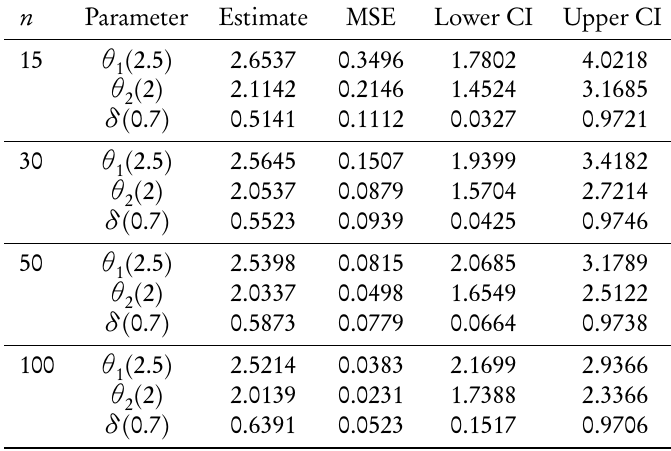
Simulation study of the parameters of BXG distribution (Case 3 -